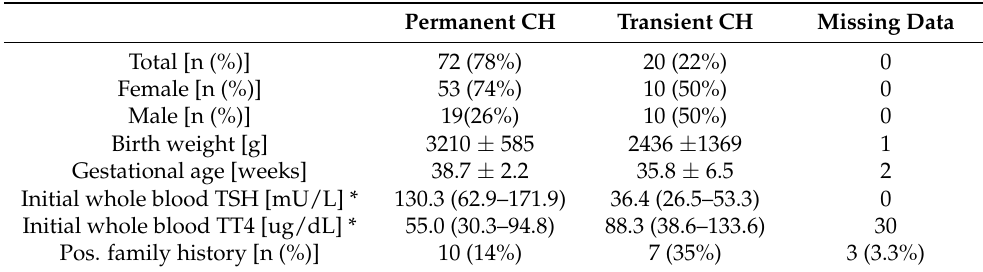
Table 1. Patient